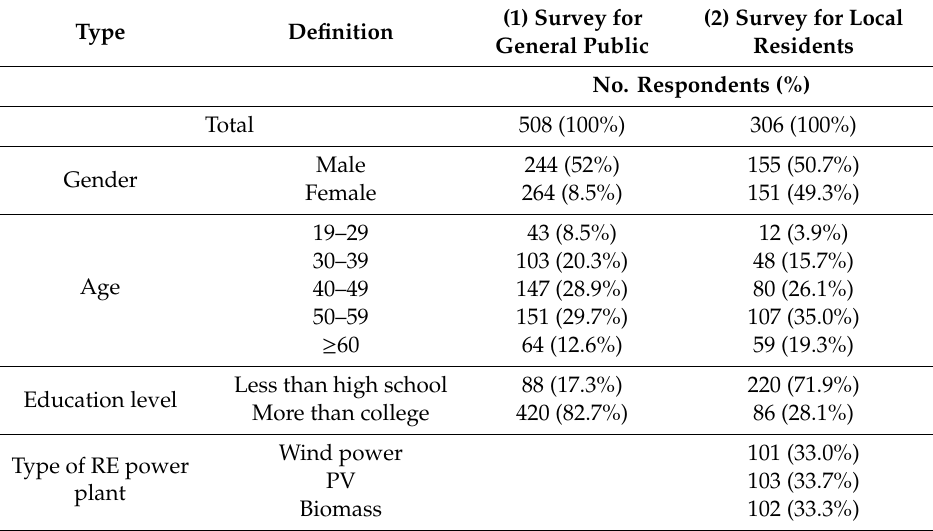
Table 4. Descriptive statistics of the